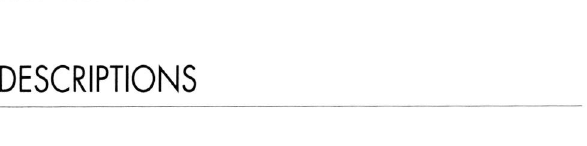
N. SP. (Fig. 2, Table I)